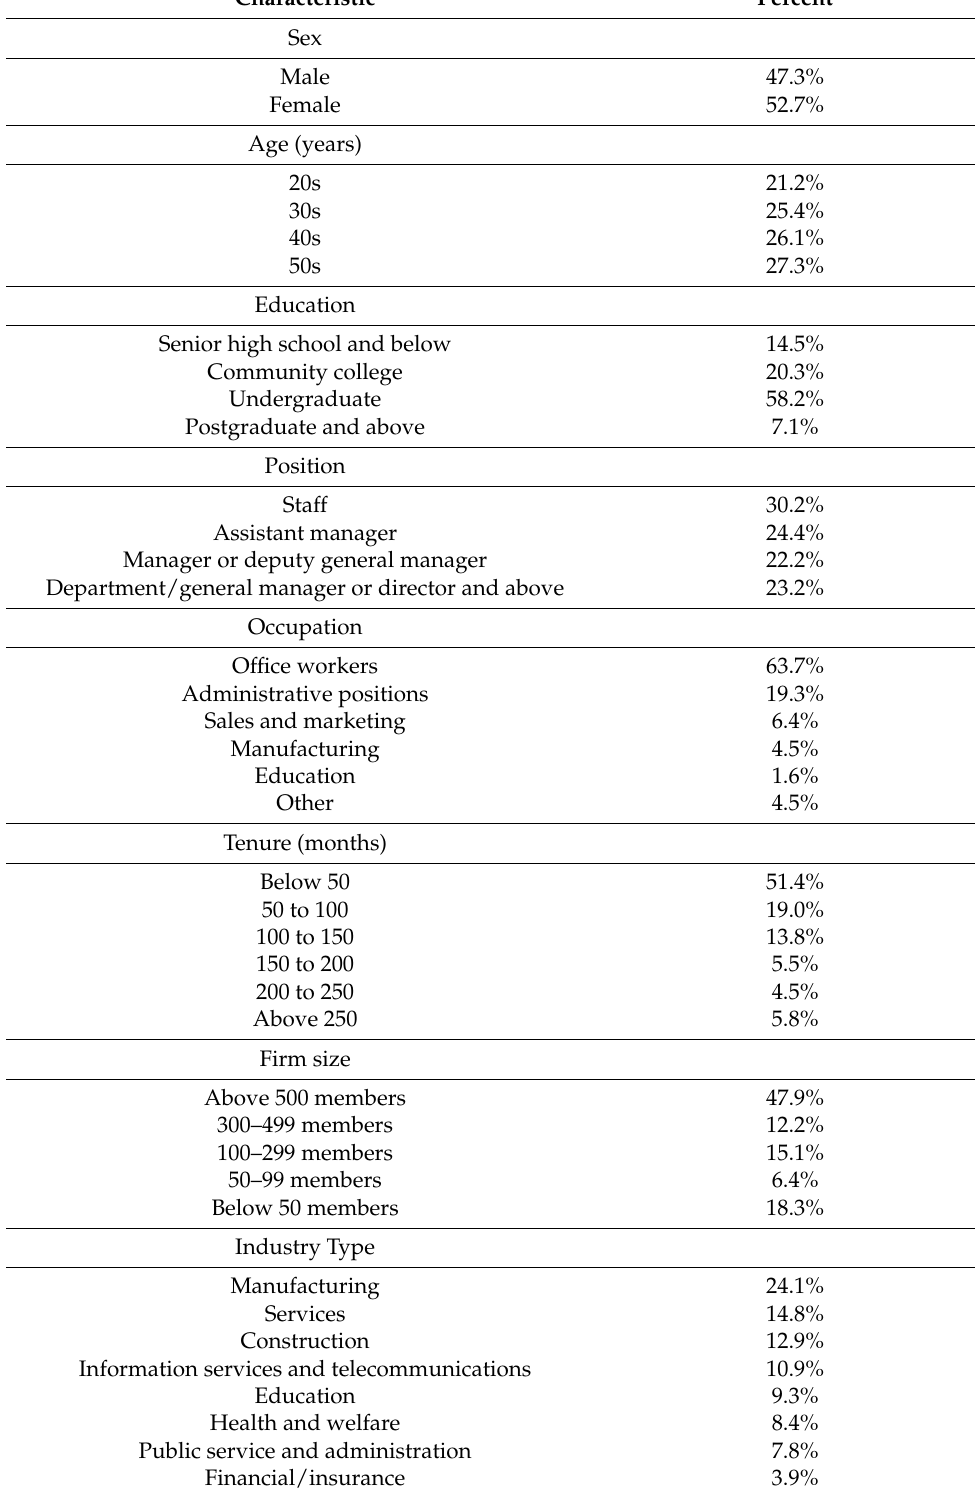
Table 1. Descriptive characteristics of the